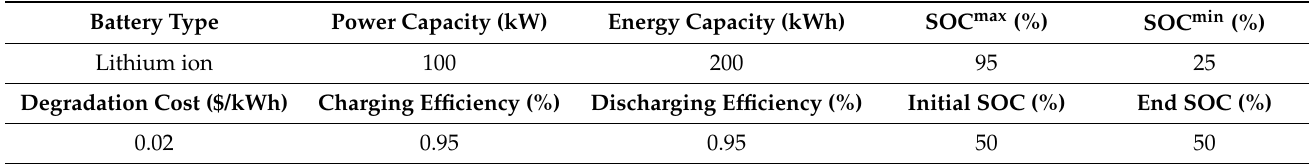
Table 3. Parameters of